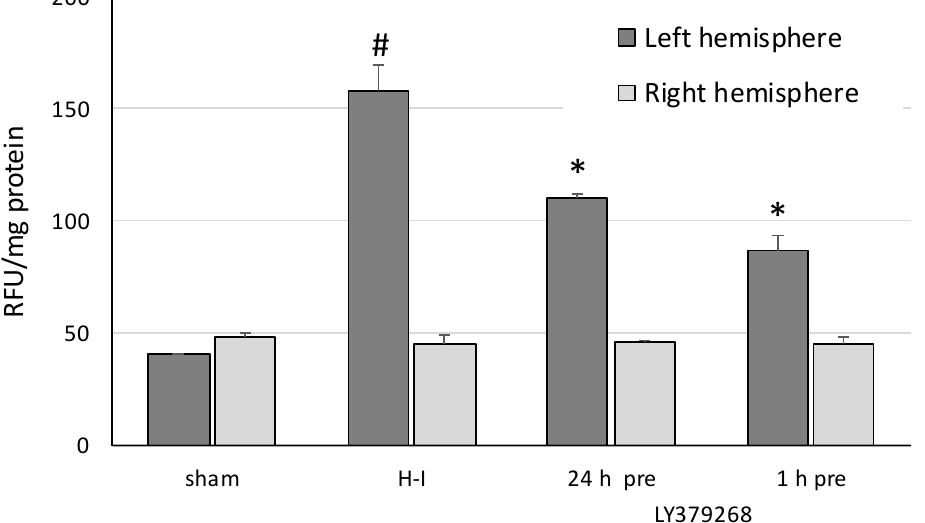
Figure 2. The effect of LY379268 pretreatment on changes in the reactive oxygen species (ROS) level evoked by H-I. The results are presented as the mean ± SD, n = 3–6; #—significantly different from the sham-operated, p < 0.005; *—significantly different from the H-I group, p < 0.005.